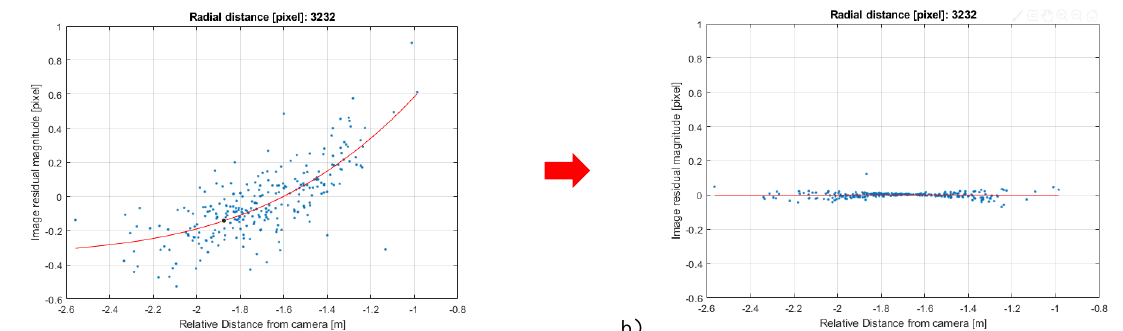
Figure 4 . Radial component of image residuals versus relative didtance from camera for a cell slice of 64 pixels at radial distances respectively of 3232 pixels before (a) and after (b) the correction. In red the estimated polynomial correction function.